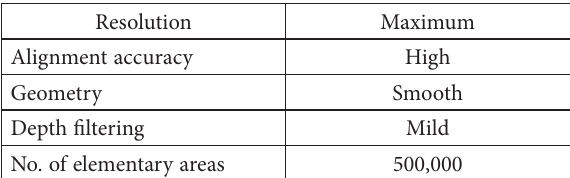
Table 4. 3D model parameters